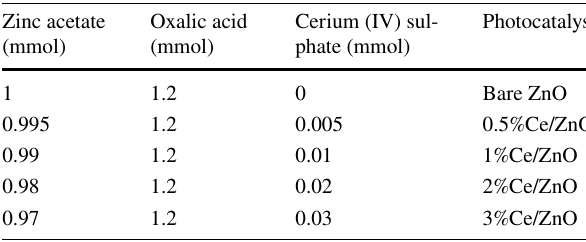
Table 1 Summary of photocatalyst